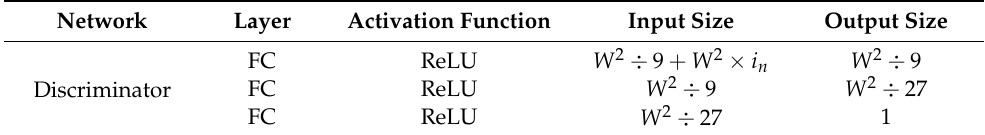
Table 4. Detail of Table 4. Detail of Discriminator.